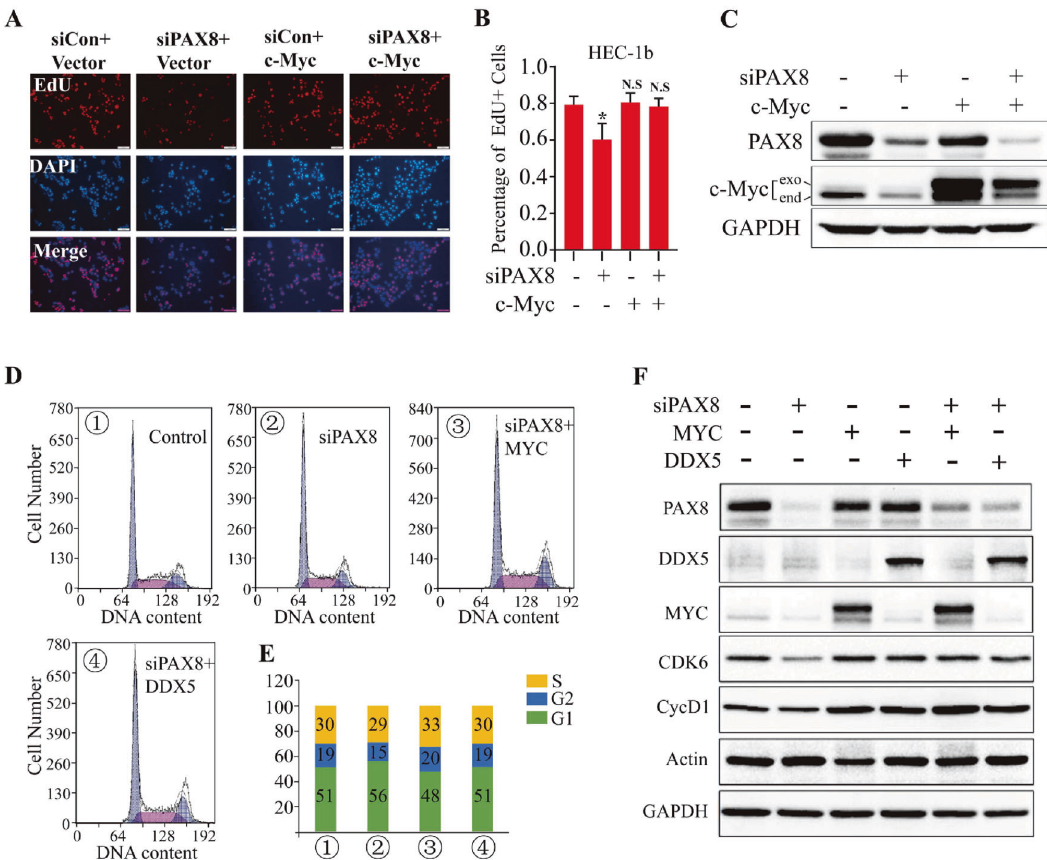
Fig. 6 PAX8 promotes UCEC cell growth and cell cycle progress dependent on DDX5 and c-MYC in vitro. A EdU incorporation assays of HEC-1b cell transiently transfected with siNC or siPAX8 or c-MYC or siPAX8 + c-MYC. B The percentage of EdU positive cells was blindly calculated with counting nine nonoverlaping fi elds. Values are means ± s.d. C HEC-1B cells were transfected with siRNAs or plasmid to knockdown PAX8 or overexpression c-MYC and DDX5, respectively. The proteins were extracted from cells for Western blotting